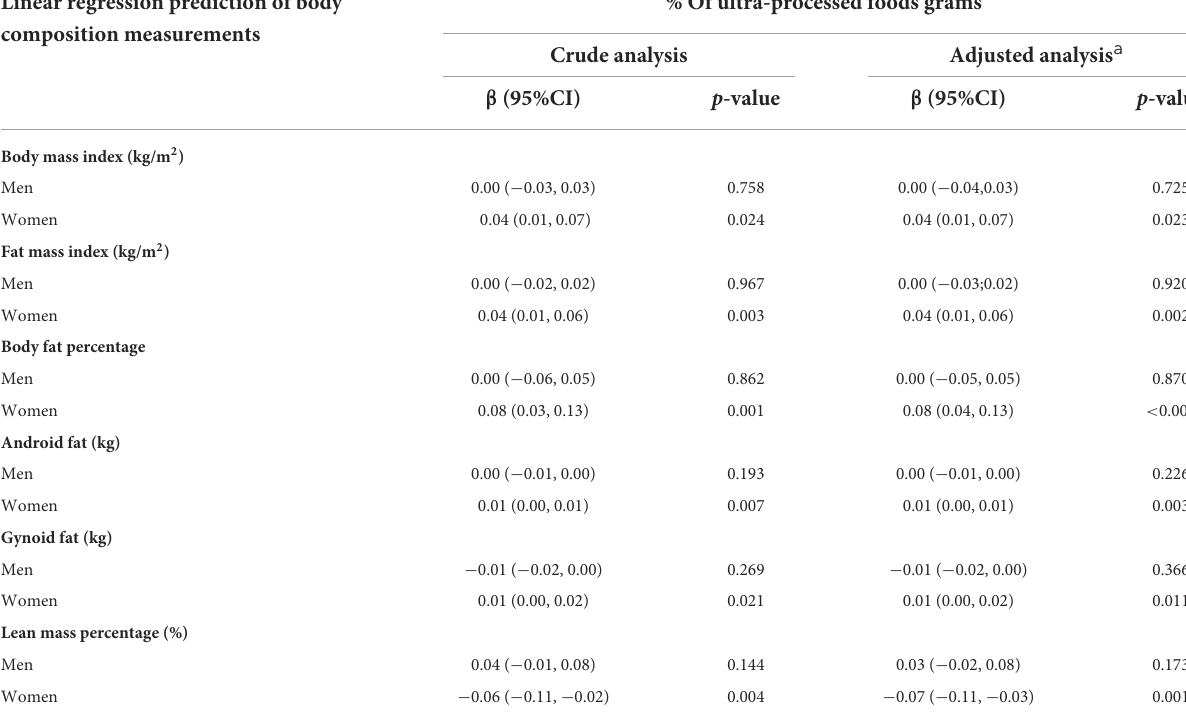
TABLE 5 Conditional effects of ultra-processed foods consumption (% grams) according to sex at 23–25 years (2002/2004) and body composition measurements at 37–39 years (2016/2017) in participants of the 1978/1979 Ribeirão Preto birth cohort study (São Paulo, Brazil). Linear regression prediction of